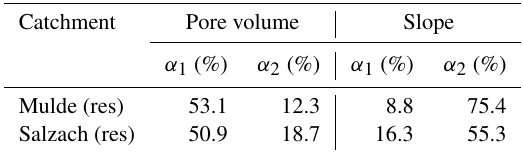
Table 2. Normalized reduction of standard deviation for resampled